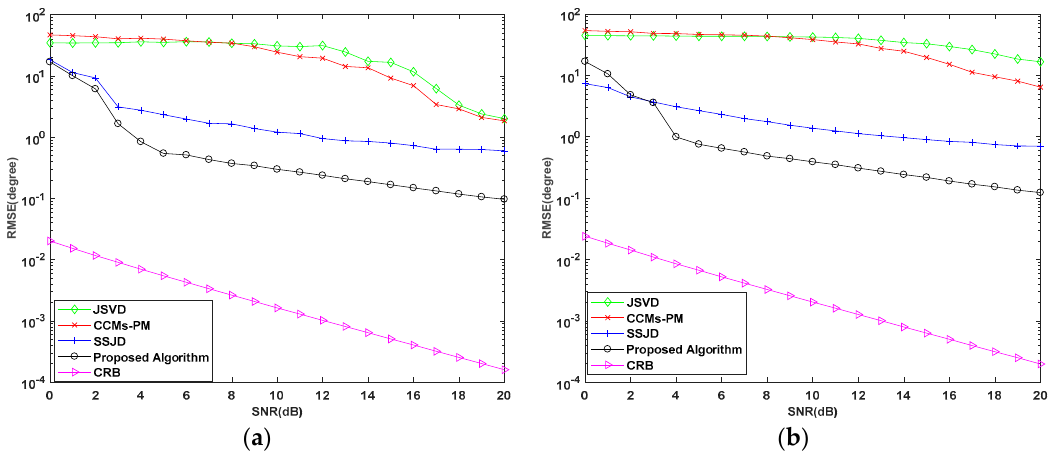
Figure 12. RMSE Performance versus SNR for different sensor spacing ( a ) d = 0.5 λ ; ( b ) d = 0.4 λ .